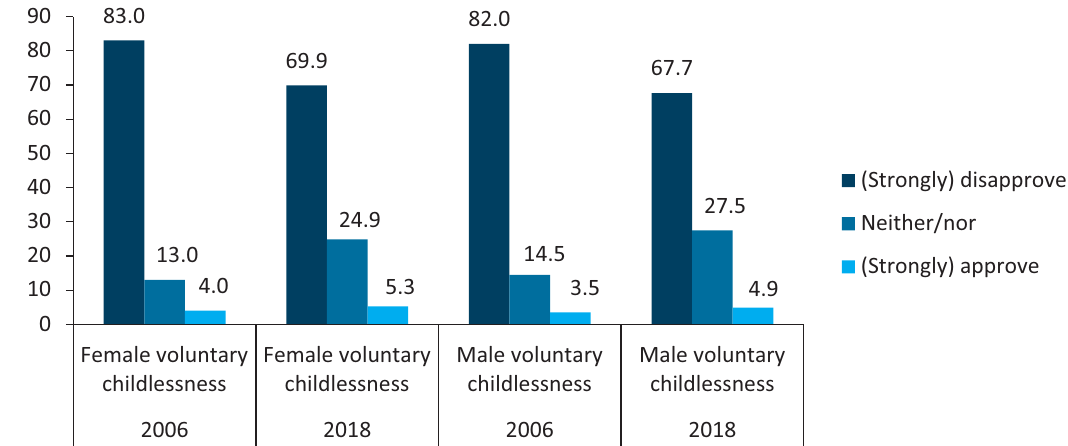
Figure 1. Attitudes toward female or male voluntary childlessness in Bulgaria. Source: ESS ERIC (2006, 2018). ESS (see Table 1). Compared to 2006 (reference year), in 2018 the respondents were less likely to reject or approve of voluntary childlessness than to be neutral (reference